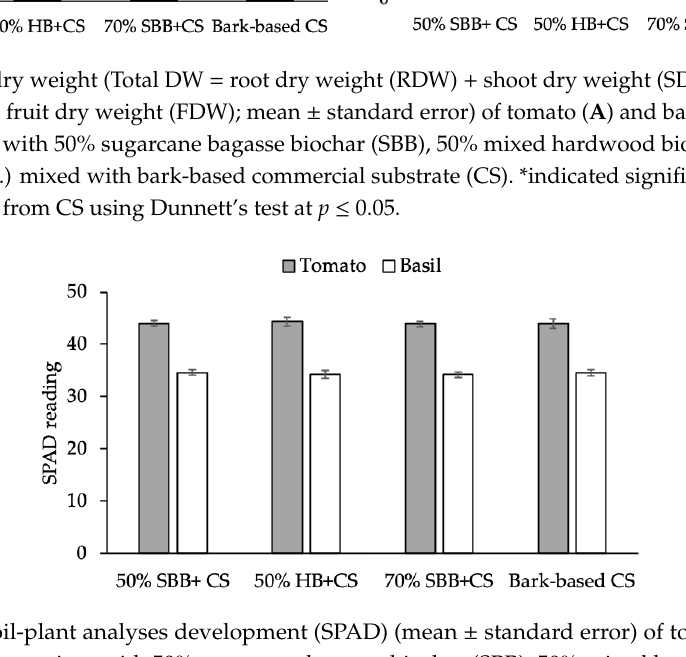
Table 2. The root development (mean ± standard error) of plants grown in potting mixes with 50% sugarcane bagasse biochar (SBB), 50% mixed hardwood biochar (HB), and 70% SBB (by vol.) mixed with bark-based commercial substrate (CS). *, **, and ***indicated significant differences from CS using Dunnett’s test at p ≤ 0.05, p ≤ 0.01, and p ≤ 0.001, respectively. Mixes